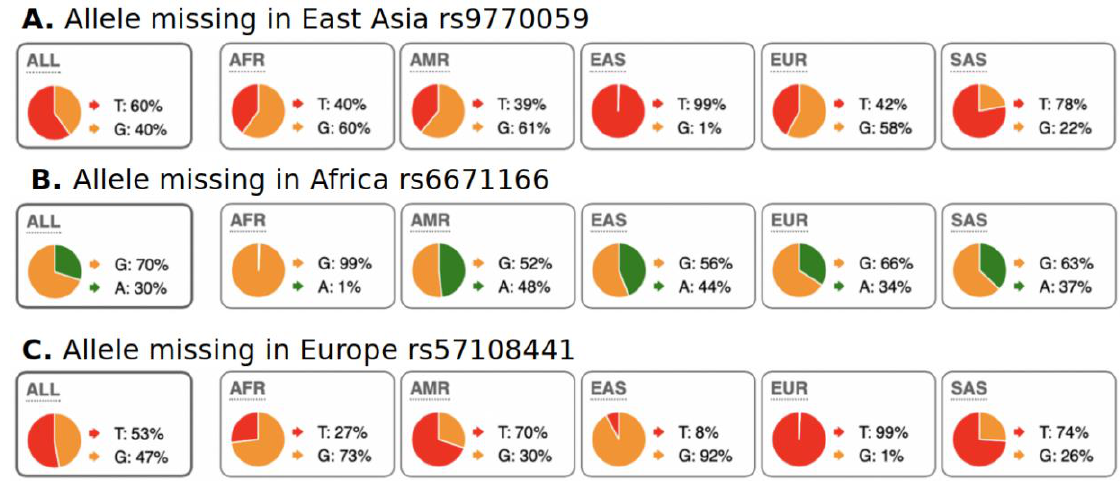
Figure 3. Examples of RACA SNPs for Africa, East Asia, and Europe. A pie chart of regional SNP allele frequencies taken from the Ensemble web site “Allele and genotype frequencies by population” (https://useast.ensembl.org/Homo_sapiens/Variation/ accessed on 20 May 2022) through SNP RS-identifiers. ( A ) Allele “G” is present globally, except for East Asia. ( B ) Allele “A” is present globally, except for Africa. ( C ) Allele “G” is present globally, except for Europe. One explanation for this phenomenon is fixation of common alleles in particular regions/continents. Distribution of RACA SNPs is shown in Table 2. Table 2. Numbers of RACA SNPs in three remote geographical regions.